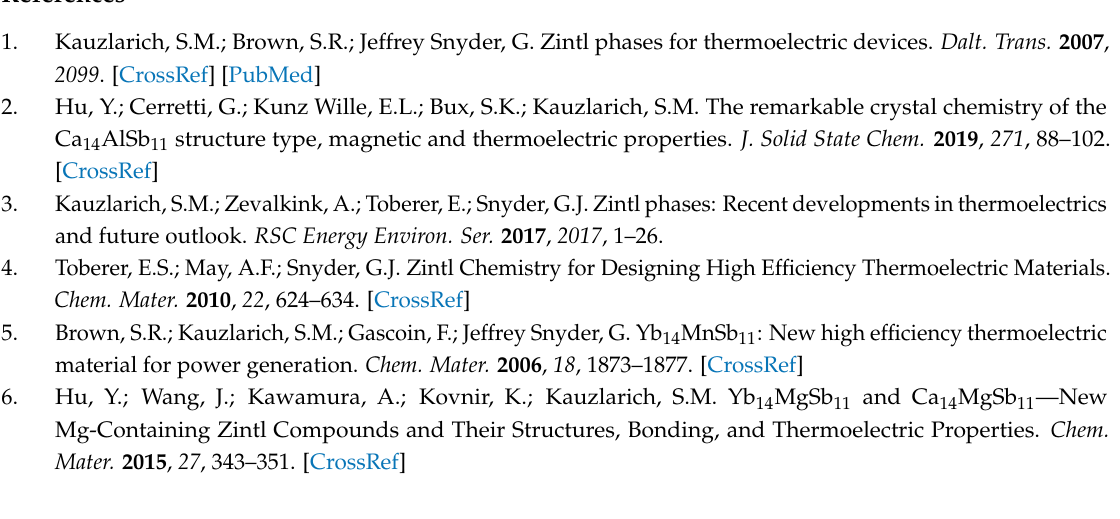
Figure S1: Microprobe backscatter electron images of (a) Yb 13.5 Y 0.5 ZnSb 11 and (b) Yb 13.5 La 0.5 ZnSb 11 , Figure S2: Powder X-Ray diffraction patterns from samples of Yb 13.5 Y 0.5 ZnSb 11 and Yb 13.5 La 0.5 ZnSb 11 , Figure S3. Electrical resistivity as a function of temperature for samples of Yb 13.5 Y 0.5 ZnSb 11 , Yb 13.5 La 0.5 ZnSb 11 and Yb 14 ZnSb 11 (data from Ref. 9). Figure S4. Seebeck as a function of temperature for samples of Yb 13.5 Y 0.5 ZnSb 11 , Yb 13.5 La 0.5 ZnSb 11 and Yb 14 ZnSb 11 (data from Ref. 9). Figure S5. Total thermal conductivity and calculated lattice thermal conductivity as a function of temperature for samples of Yb 13.5 Y 0.5 ZnSb 11 , Yb 13.5 La 0.5 ZnSb 11 and Yb 14 ZnSb 11 (taken from Ref.